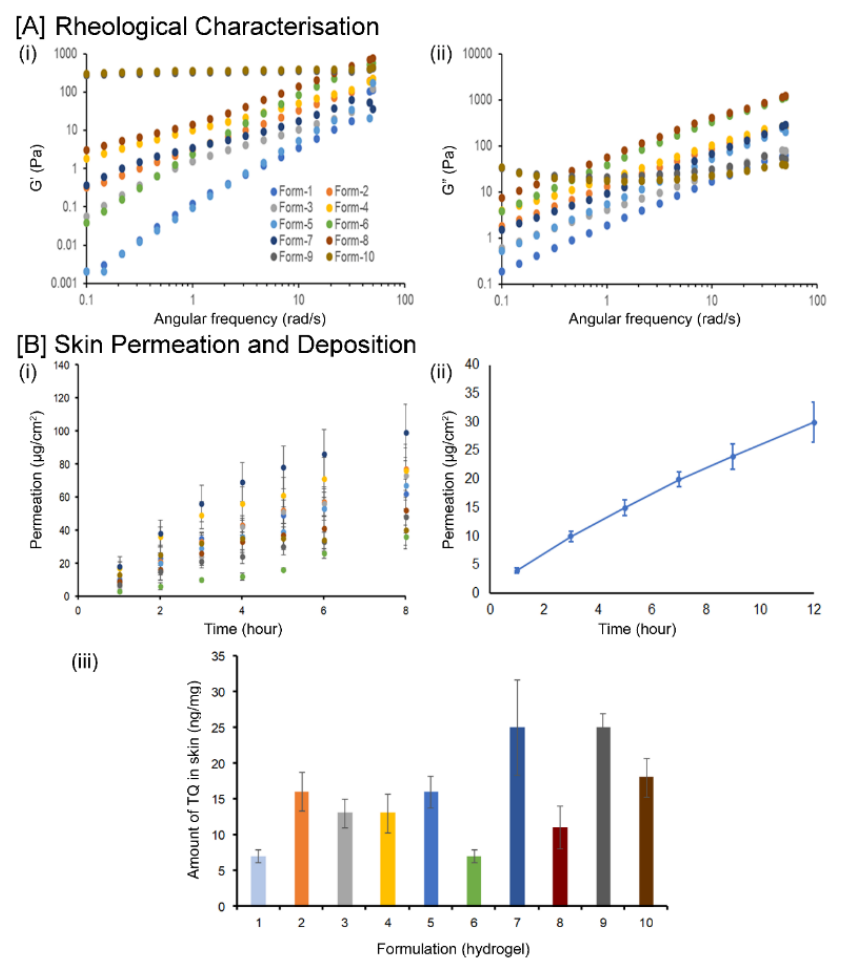
Figure 3. Rheological characterization of TQ hydrogel formulations (F1–F10). ( A ) Oscillation frequency sweep data. The elastic modulus (i); The viscous modulus (ii) were plotted against angular frequency. TQ permeation and skin deposition from film and gel formulations ( B ). TQ permeation profile for di ff erent hydrogel formulations (i). Time points were measured at 1, 2, 3, 4, 5, 6, and 8 h. Each point represents the five experiments; TQ permeation from film formulation across human cadaver skin ( n = 5) (ii); Amount of TQ detected after 8 h in human cadaver skin ( n = 5) using di ff erent TQ hydrogel formulations